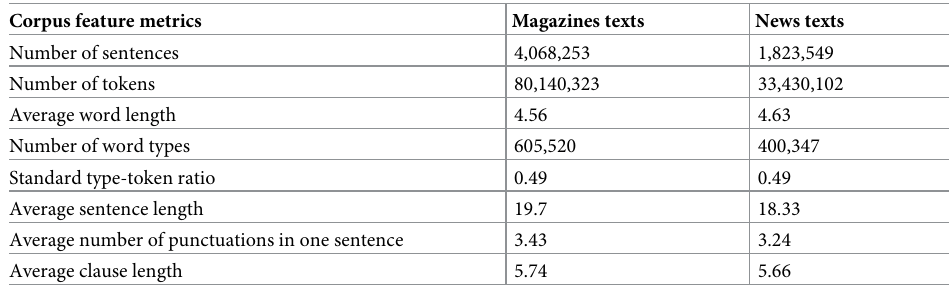
Table 1. Magazines and news corpus feature